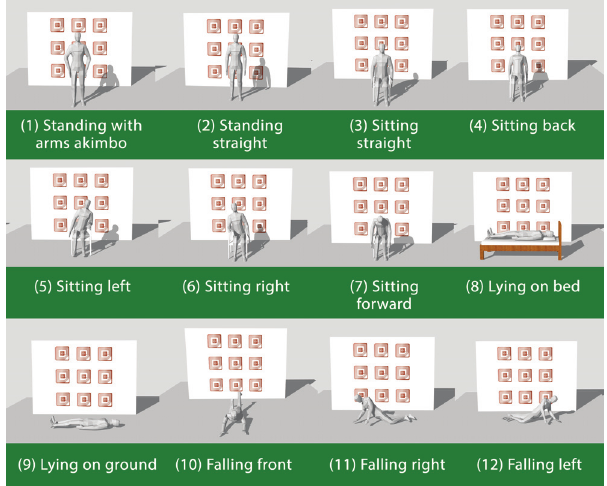
Figure 9: Predefined orientation-sensitive postures